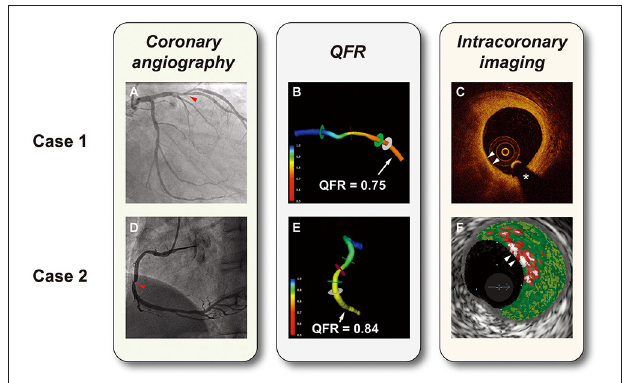
FIGURE 1 | Representative cases of hemodynamic and intravascular evaluations. (A) Coronary angiography showed a lesion with 50% diameter stenosis in the left anterior descending artery (the red arrow). (B) 3D vessel reconstruction with a QFR of 0.75. (C) OCT-TCFA: a lipid-rich plaque with the thinnest fibrous cap < 65 µ m (white arrows). (D) Coronary angiography showed a lesion with 50% diameter stenosis in the right coronary artery (the red arrow). (E) 3D vessel reconstruction with a QFR of 0.84. (F) VH-caTCFA (white arrows): necrotic core is coded as red, dense calcium as white, fibrous tissue as dark green, and fibrofatty tissue as light green. *guidewire artifact. QFR, quantitative flow ratio; OCT-TCFA, optical coherence tomography-thin cap fibroatheroma; VH-caTCFA, virtual histology-calcified thin cap fibroatheroma.